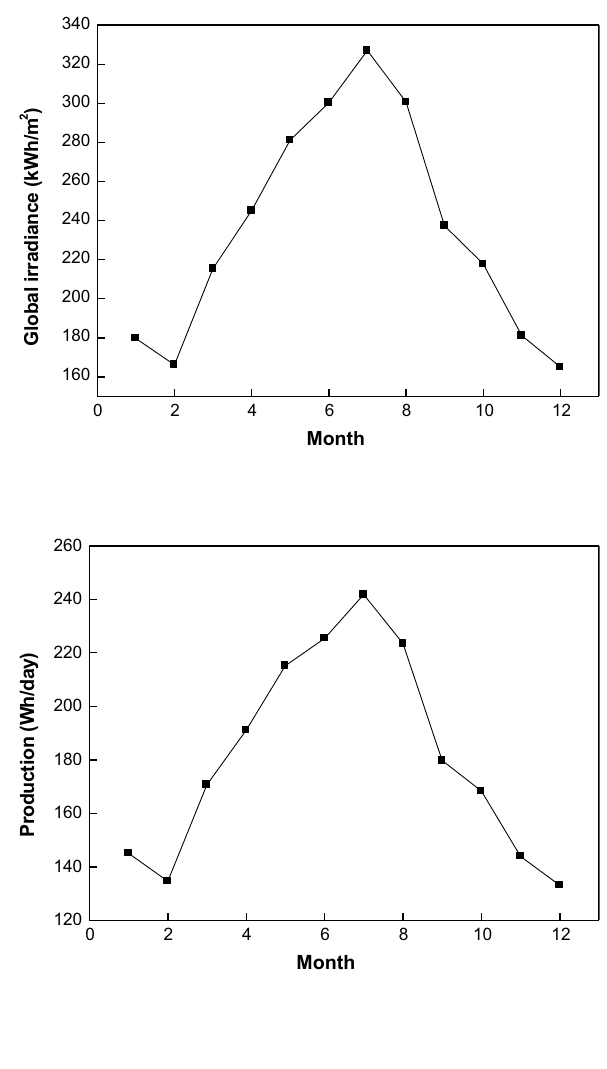
Fig. 4 Estimation of global irradiance gathered by the modules solar cell